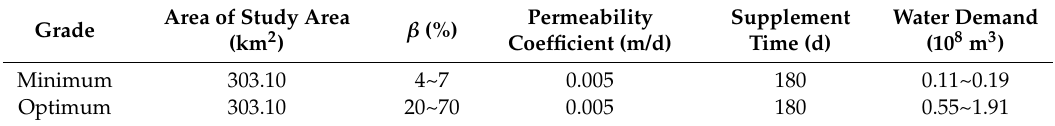
Table 5. Water demand for supplying groundwater.